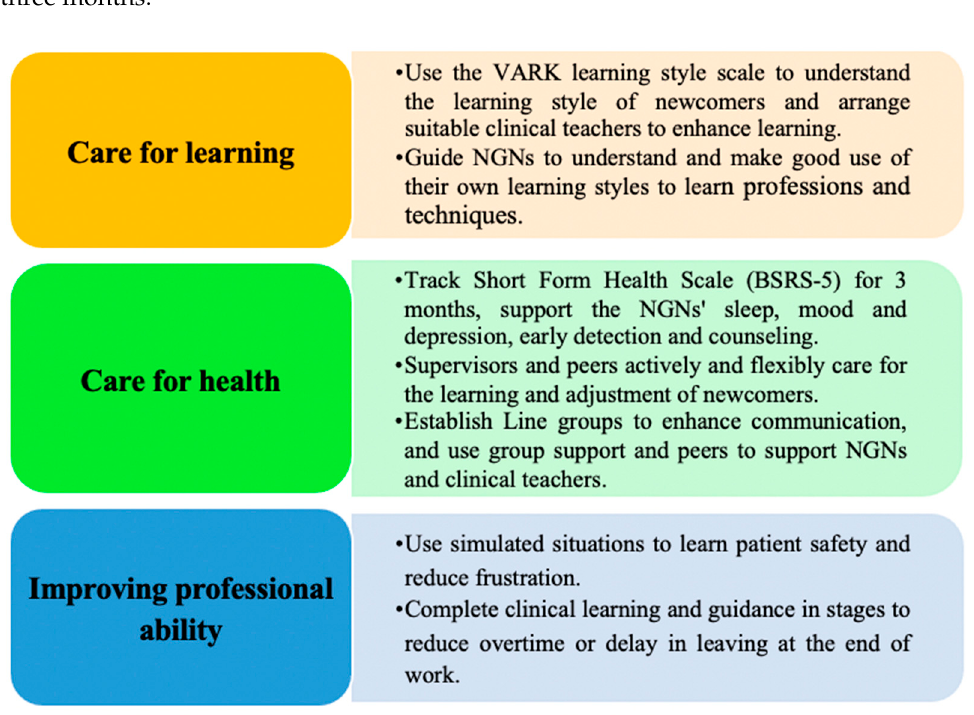
Figure 1. The three adaptive parts of the education